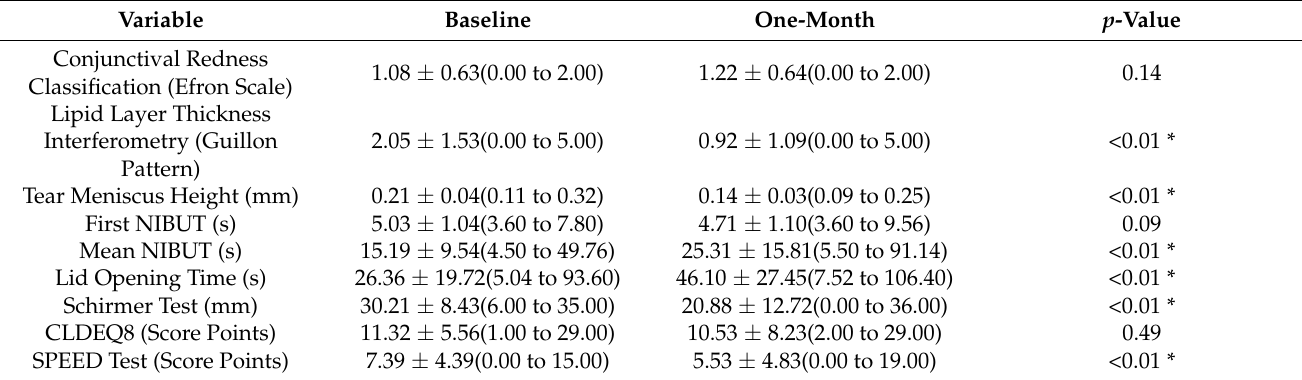
Table 2. Ocular surface longitudinal changes before and after silicone hydrogel